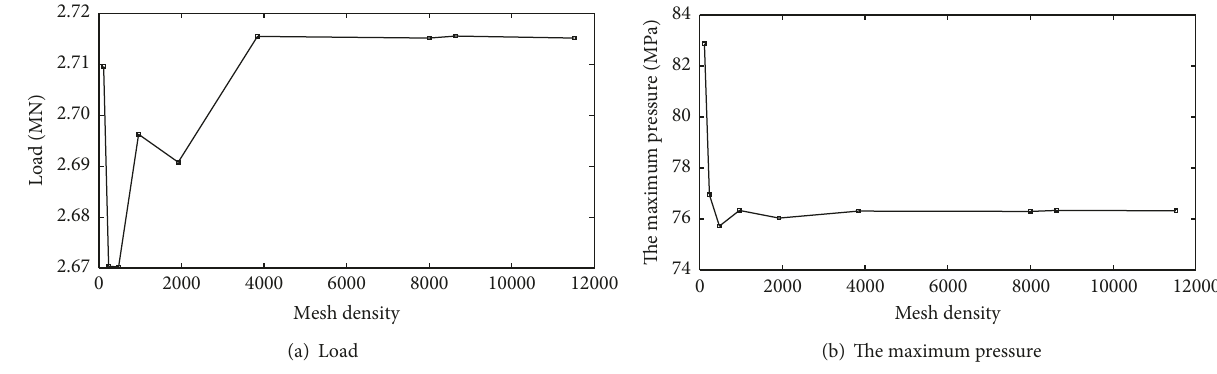
Figure 3: Variation of the load and the maximum pressure with mesh density.